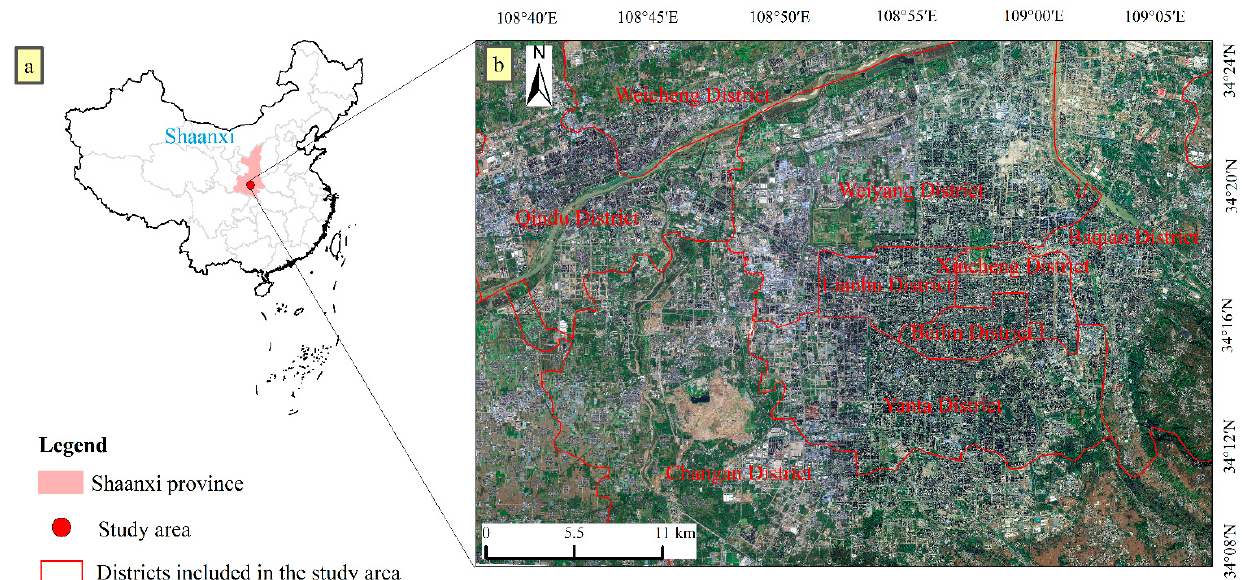
Figure 1. Location of Shaanxi Province and the study area in China ( a ); schematic view of the main city of Xi’an from a GF-6 image ( b